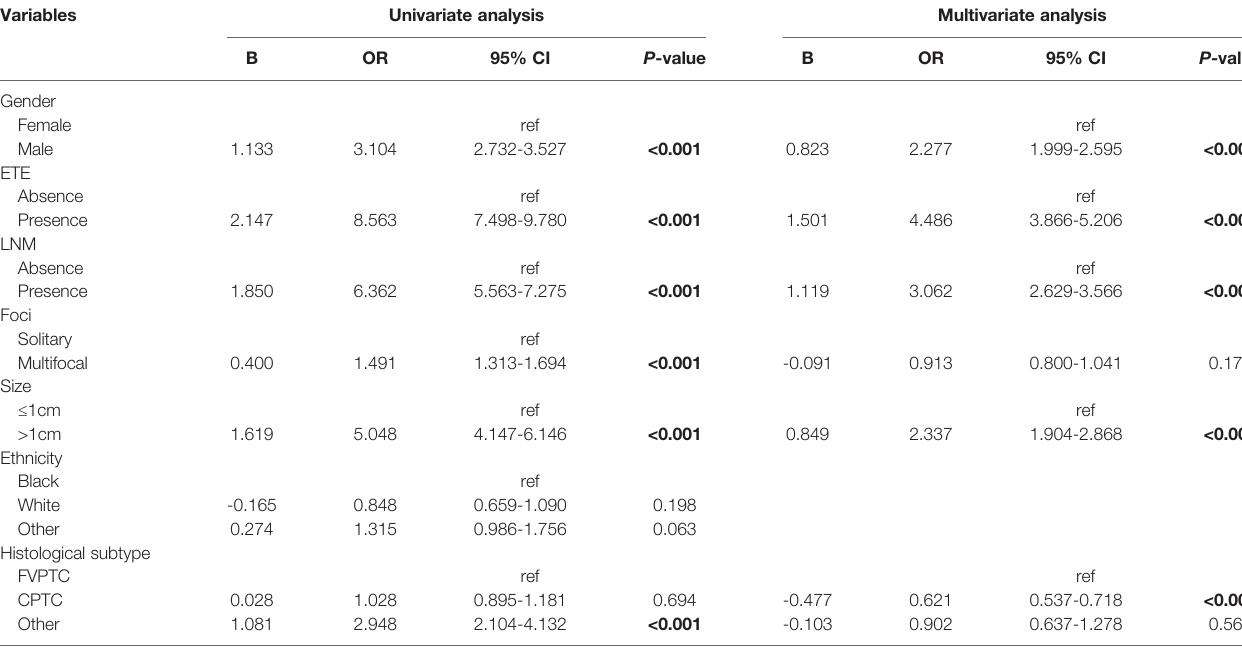
TABLE 5-2 | Risk factors of distant metastasis in adult patients calculated by logistic regression